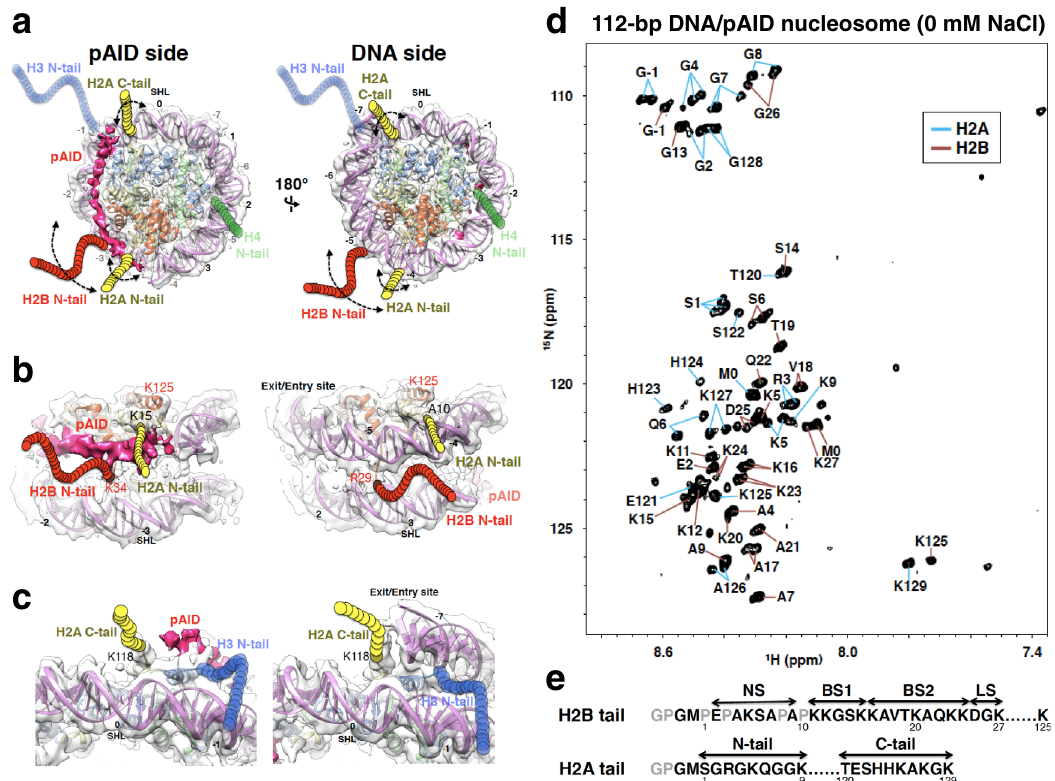
Fig. 1 2D 1 H- 15 N HSQC spectrum of the H2A and H2B tails in the 112-bp DNA/pAID nucleosome. a – c Cryo-EM structure of the 112-bp DNA/pAID nucleosome. Six views of the EM density map (EMD-9639) are superimposed on the nucleosome structure (PDB ID: 2CV5) lacking the 33-bp DNA. Visualization of the EM maps and fi tting of the nucleosome structures in the maps were performed using UCSF Chimera 67 . pAID is shown as deep pink density. H2A, H2B, H3, H4, and DNA are colored yellow, red, blue, green, and orchid, respectively. Colored circular chains denote individual histone tails, which are not observed in the EM structure. Superhelix locations (SHL), representing the number of double turns from the dyad axis of the canonical nucleosome (0), are indicated. d Backbone resonance assignments of the 112-bp DNA/pAID nucleosome in the 2D 1 H- 15 N HSQC spectrum recorded in 20 mM HEPES-NaOH, pH 7.0, 10% D 2 O on a 950-MHz spectrometer. Blue and orange lines indicate residues of H2A and H2B, respectively. e Amino acid sequences of the H2A and H2B tails. Assigned and unassigned residues in NMR are colored black and gray,